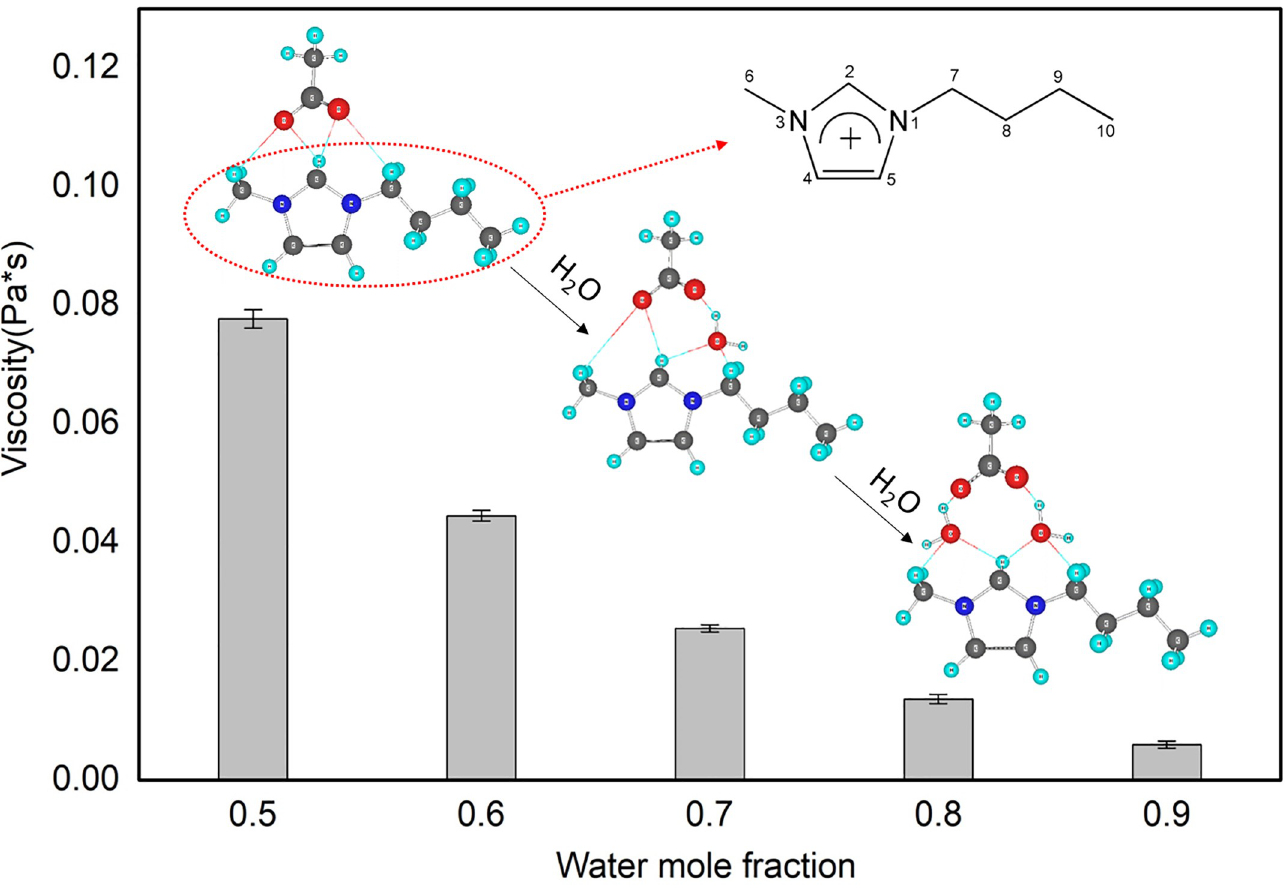
Fig 2. Viscosity and dispersion state of [C4mim]Ac aqueous solutions with different IL/water mole fractions.